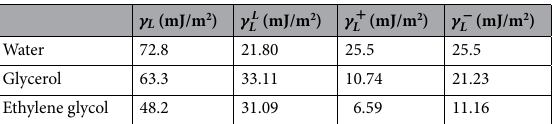
Table 3. Lifshitz-van der Walls components and electron-donor parameters used in the simulation 29,30,34 .